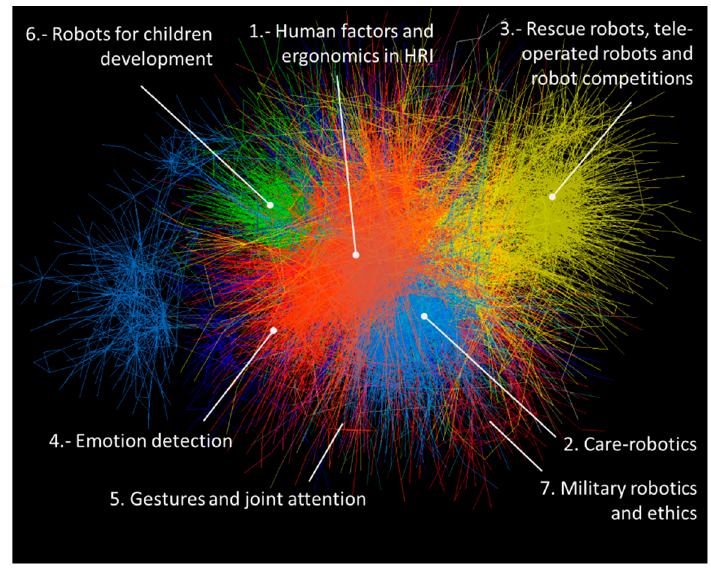
Figure A1. Visualization of seven sub-clusters of human-robot interaction (HRI).